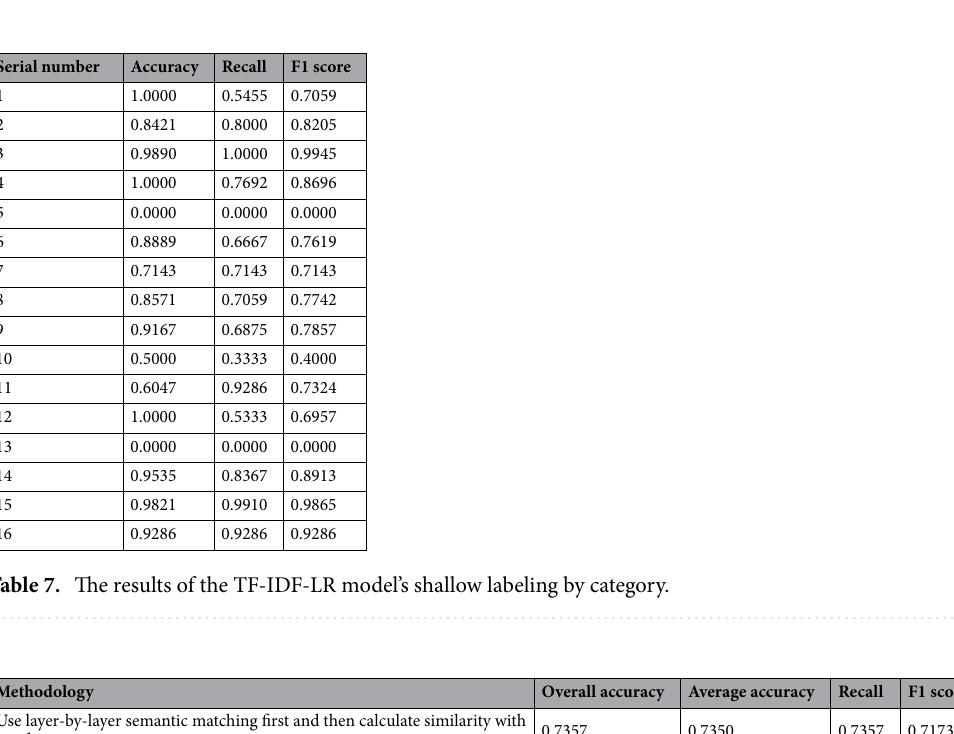
Table 6. The results of the BERT model’s shallow labeling (without text enhancement) by category.